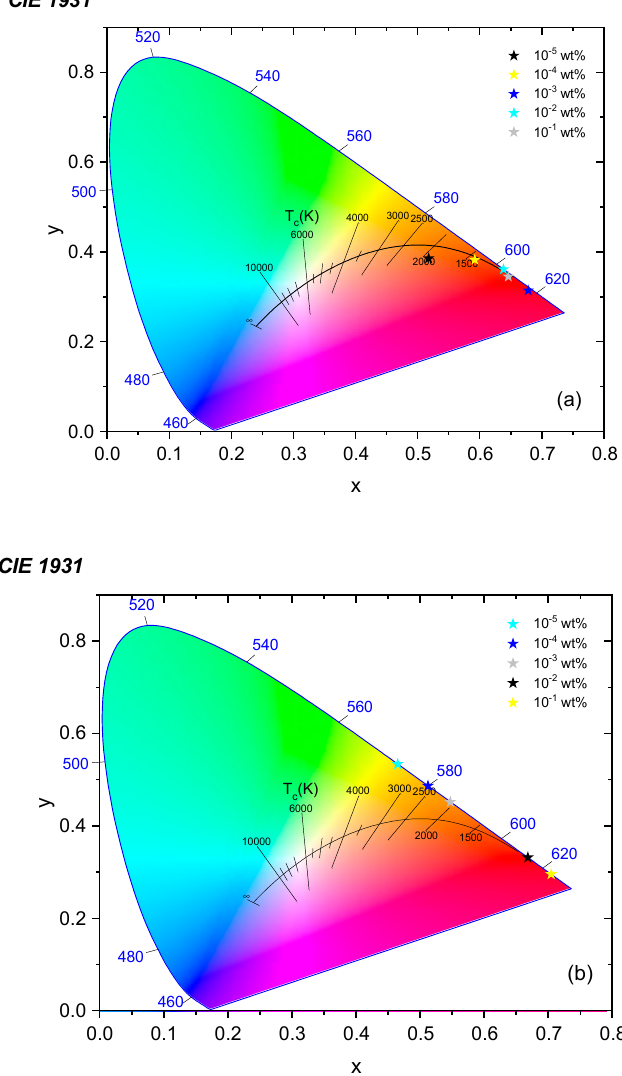
Figure 7. Chromaticity diagram of photoselective PMMA greenhouse films doped with ( a ) KRE- 94720 and ( b ) KREMER MER 94720 and ( b ) KREMER 94739.